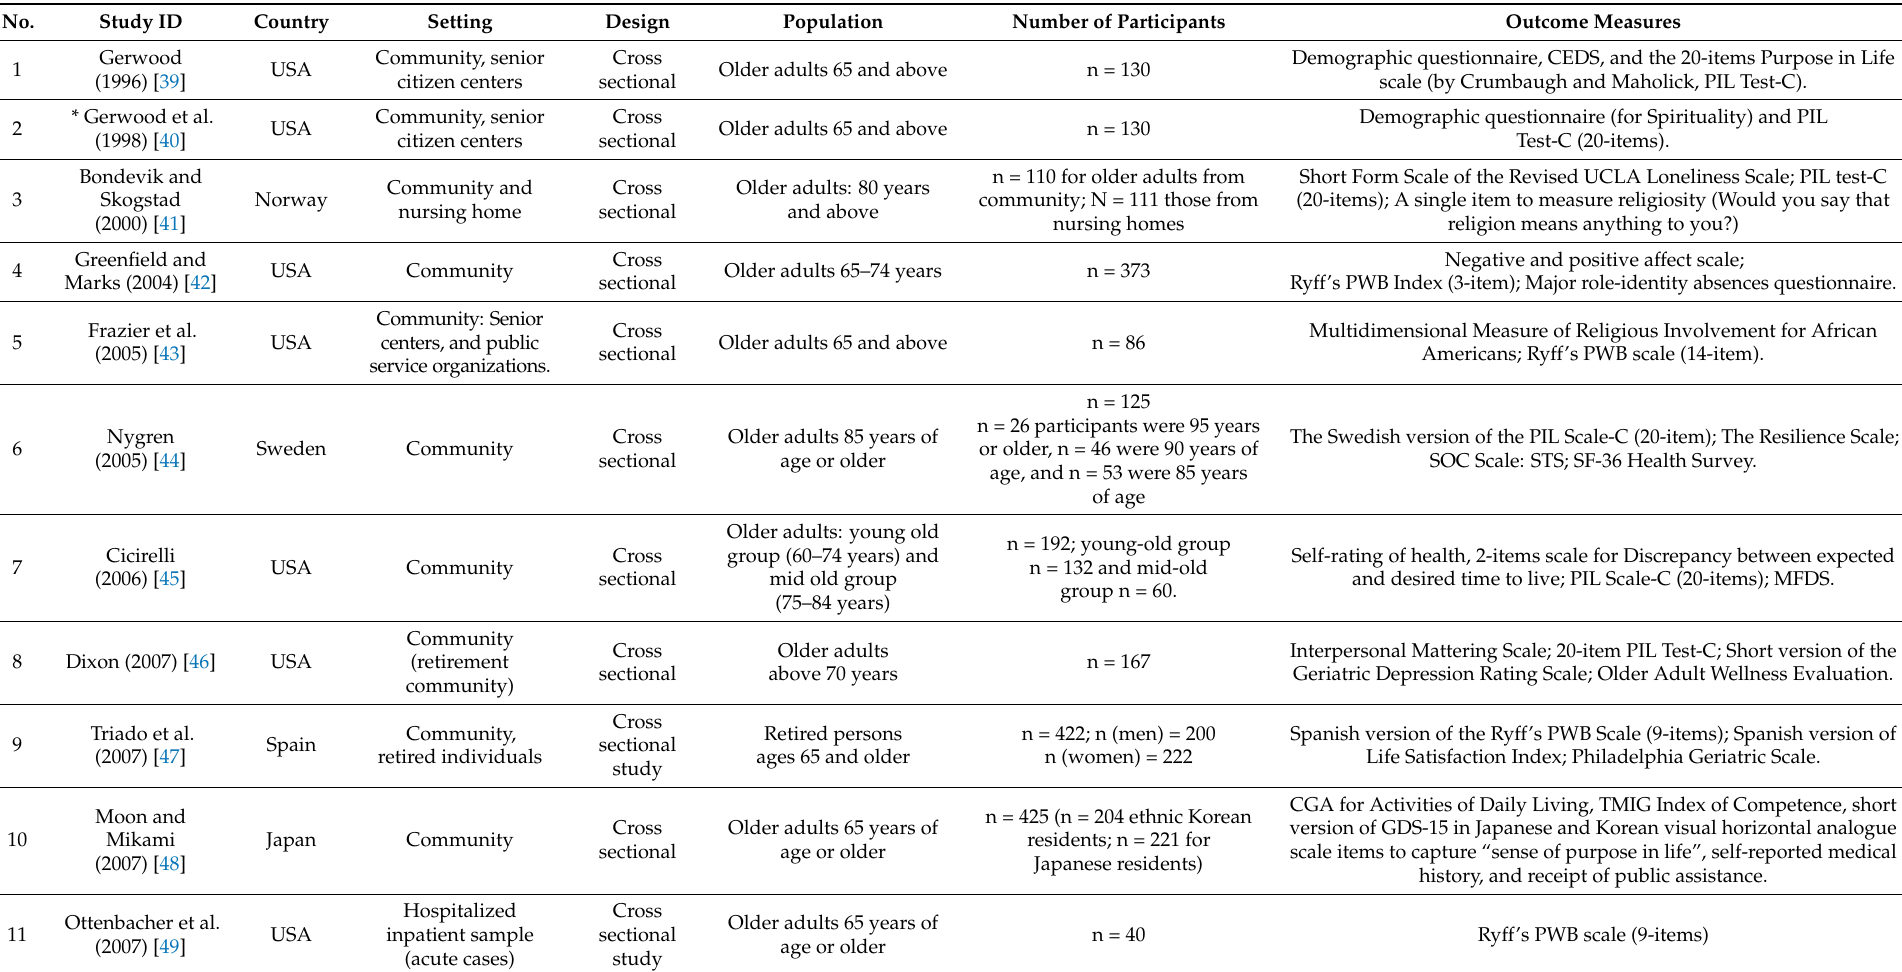
Table 1. Study characteristics of the included studies and measures